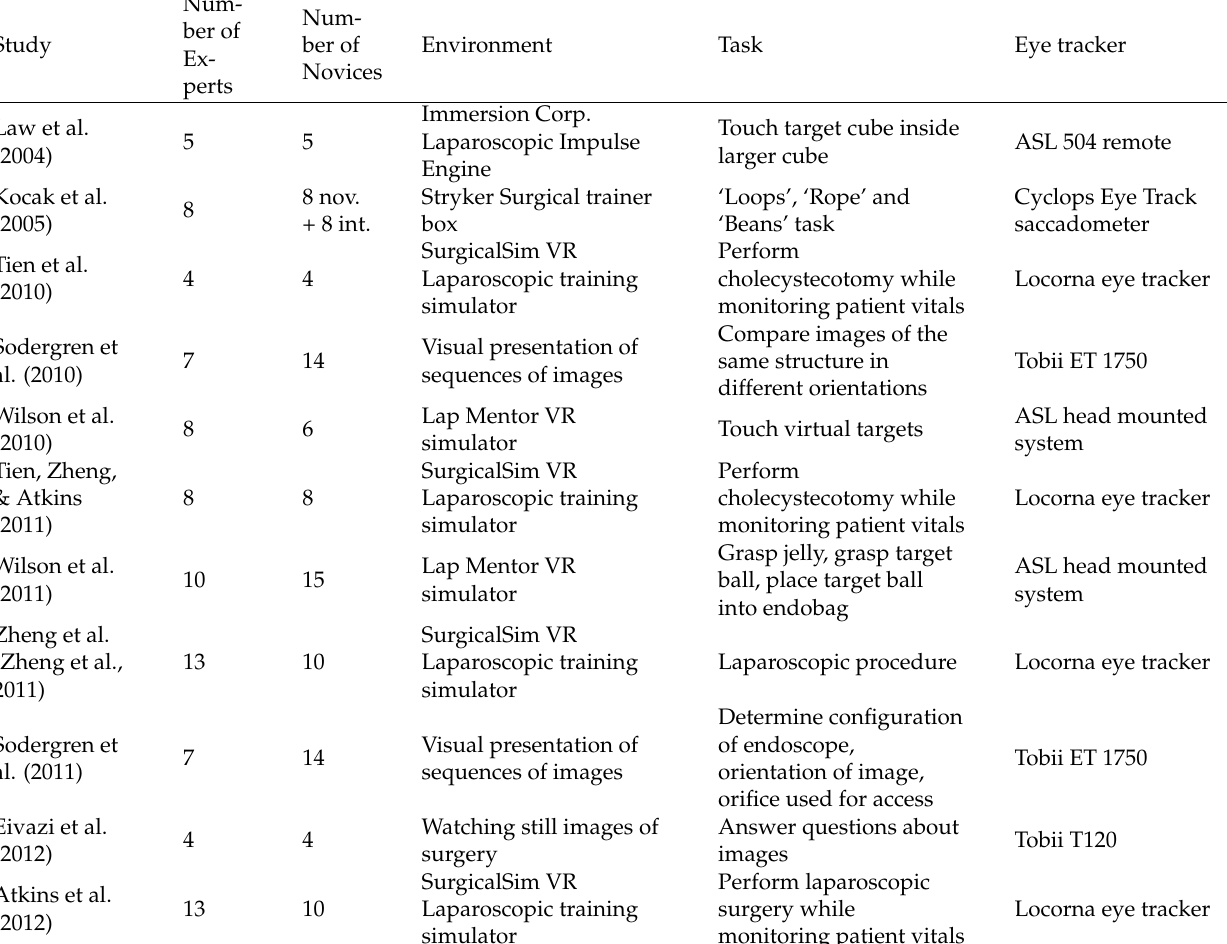
Overview of the methods of each of the studies comparing eye movements in experts and novices surgeons, listing the number of experts and novices in each study, the environment in which the eye movements were recorded, the task being performed by the research participants, and the eye tracking equipment used. The studies are ordered